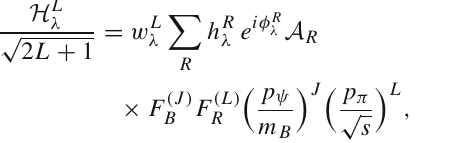
tem M 1 M 2 ; in particular, there are chiral symmetry relations between the different dimeson channels that fix the relative strengths to be equal to those of the matrix elements in Eq.